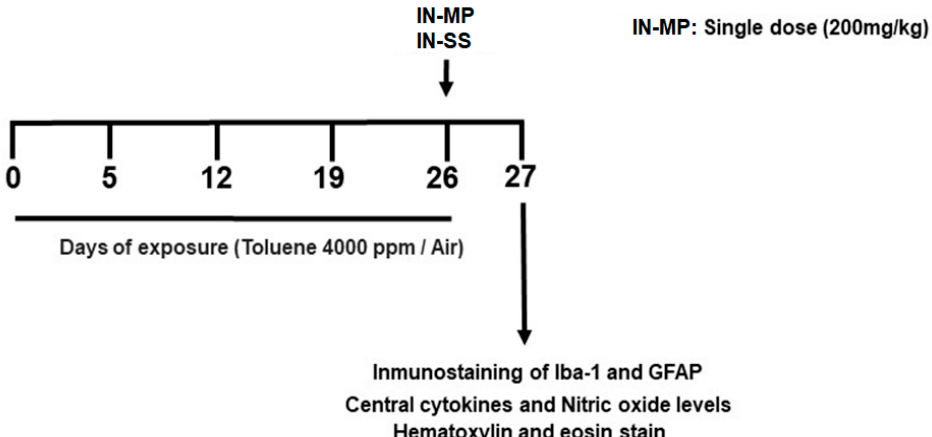
Figure 1. Experimental design. At the beginning animals were exposed to toluene 4000 ppm or air for four weeks. Two hours after the last exposure the animals received a single dose of intranasal MP (IN-MP) or intranasal SS (IN-SS). One day later, the expressions of Iba-1 and GFAP were assayed by immunofluorescence and central cytokines and nitric oxide levels were evaluated by enzyme-linked immunosorbent assay (ELISA) and Griess reaction, respectively. Histological analysis was performed with hematoxylin and eosin staining 24 h after the treatment.